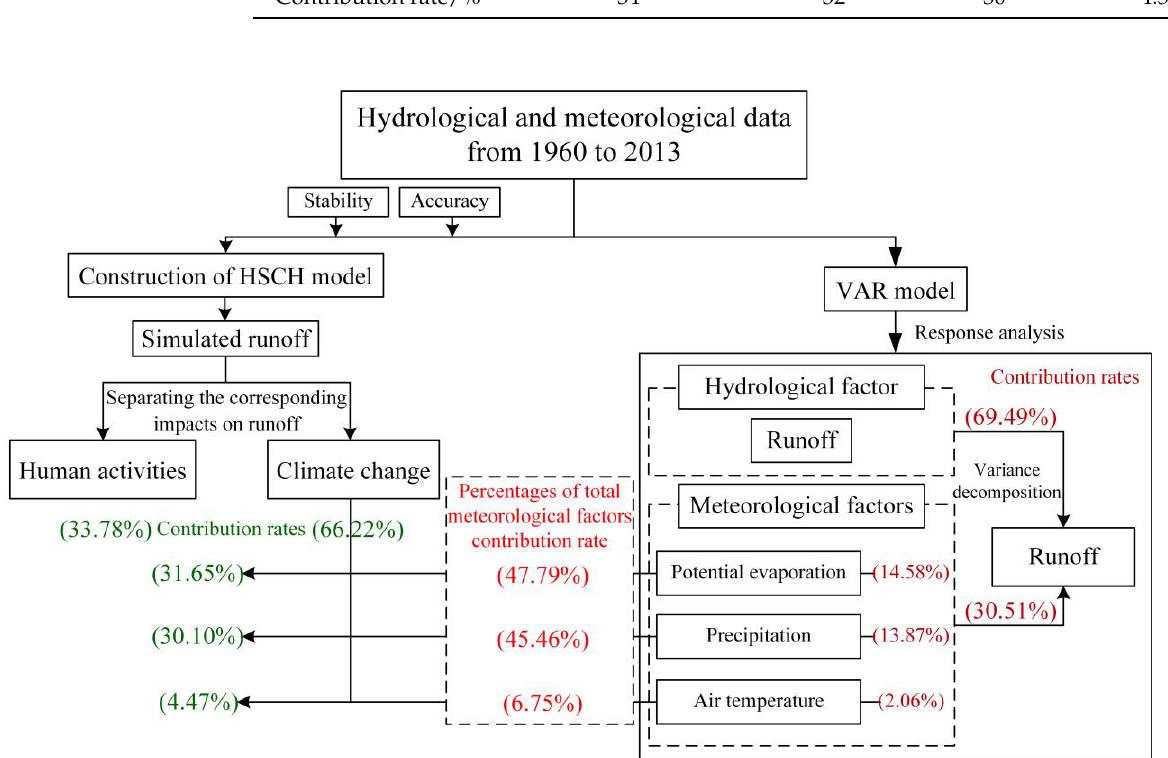
Figure 12. Process of separating the contribution rates of meteorological factors to runoff.